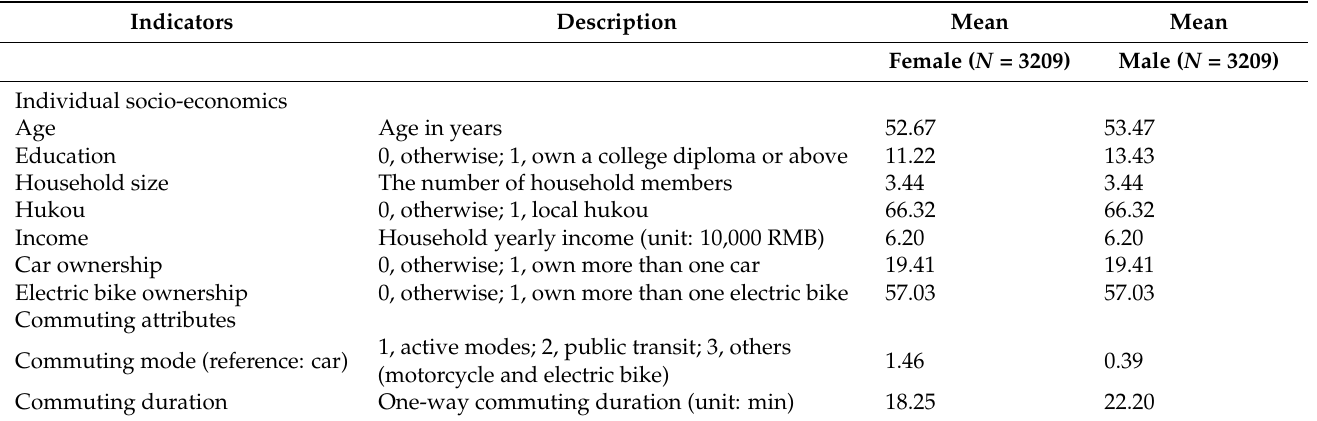
Table 2. Statistical descriptions of variables at the individual